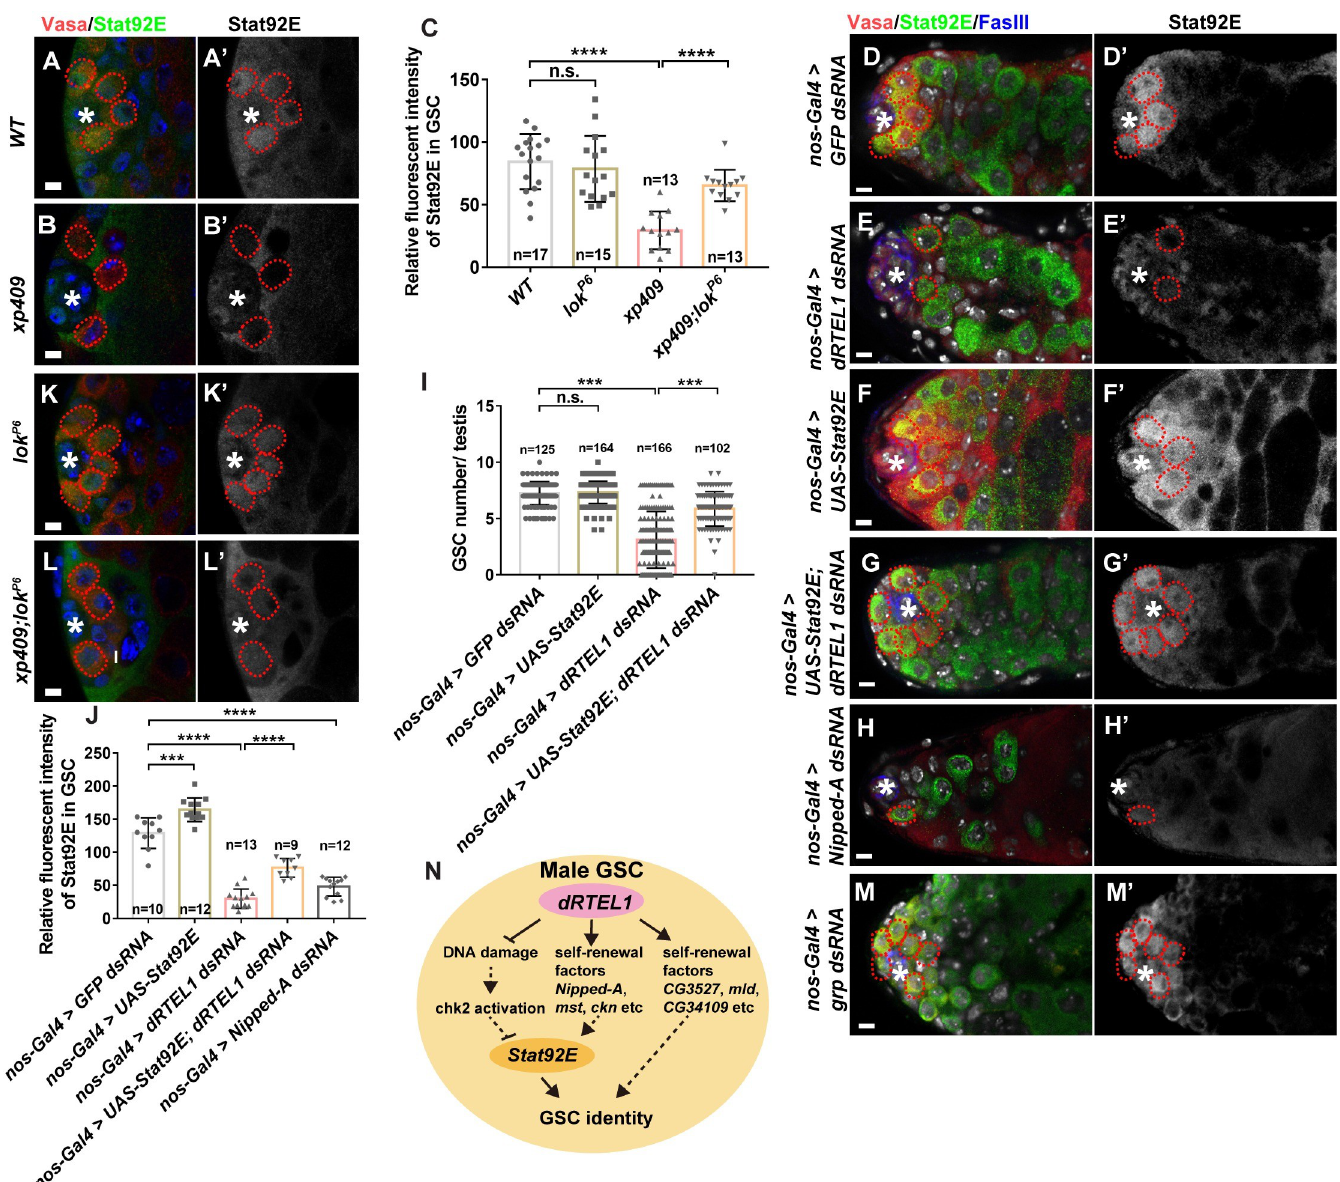
Fig 8. dRTEL1 promotes Stat92E expression. (A-B’) Representative confocal images of larval testis at 72hr ALH showing Stat92E expression in WT (A,A’) and xp409 (B,B’). (C) Quantification of the relative fluorescent intensity of Stat92E in GSC in various backgrounds. Number in each bar represents the number of testes examined. (D-H’) Representative confocal images of D14 adult testis showing Stat92E expression in nos-Gal4 > GFP dsRNA (D,D’), nos-Gal4 > dRTEL1 dsRNA (E,E’), nos- Gal4 > UAS-Stat92E (F,F’), nos-Gal4 > UAS-Stat92E; dRTEL1 dsRNA (G,G’) or nos-Gal4 > Nipped-A dsRNA (H,H’). (I) Quantification of the GSC number per testis in various backgrounds. Number in each bar represents the number of testes examined. (J) Quantification of the relative fluorescent intensity of Stat92E per GSC in various backgrounds. Number in each bar represents the number of testes examined. (K-L’) Representative confocal images of larval testis at 72hr ALH showing Stat92E expression in lok P6 (K,K’) and xp409;lok P6 (L,L’). Data are mean ± s.e. n.s., not significant, � , P < 0.05, �� , P < 0.01, ��� , P < 0.001. (M-M’) Representative confocal images of D14 adult testis showing Stat92E expression in nos-Gal4 > grp dsRNA . (N) Schematic image showing the role of dRTEL1 in fly male GSCs. The hub is indicated by asterisks. GSCs are indicated by red dotted circles. DNA (TO-PRO-3) is in white in D-H and M and blue in A-B and K-L. Scale bars: 5 μ m (A, B, and K-L) and 10 μ m (D-H and